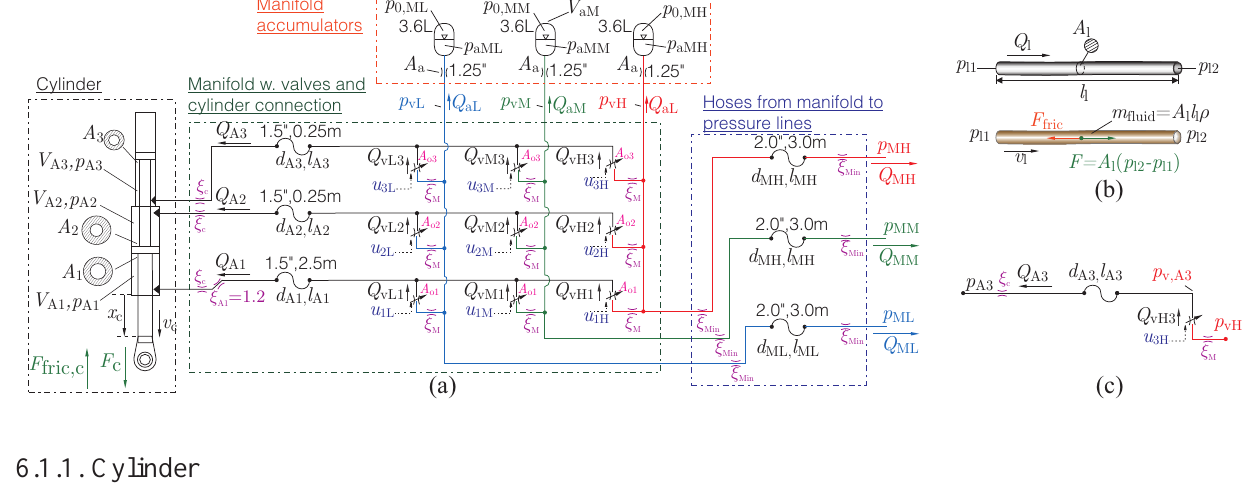
Figure 13. ( a ) diagram of DDC-system, consisting of cylinder, manifold with nine on/off valves, accumulators and pipe lines. Fitting are indicated, where ξ denotes the fitting resistance coefficient; ( b ) illustration of hose model; and ( c ) illustration for combined valve and hose